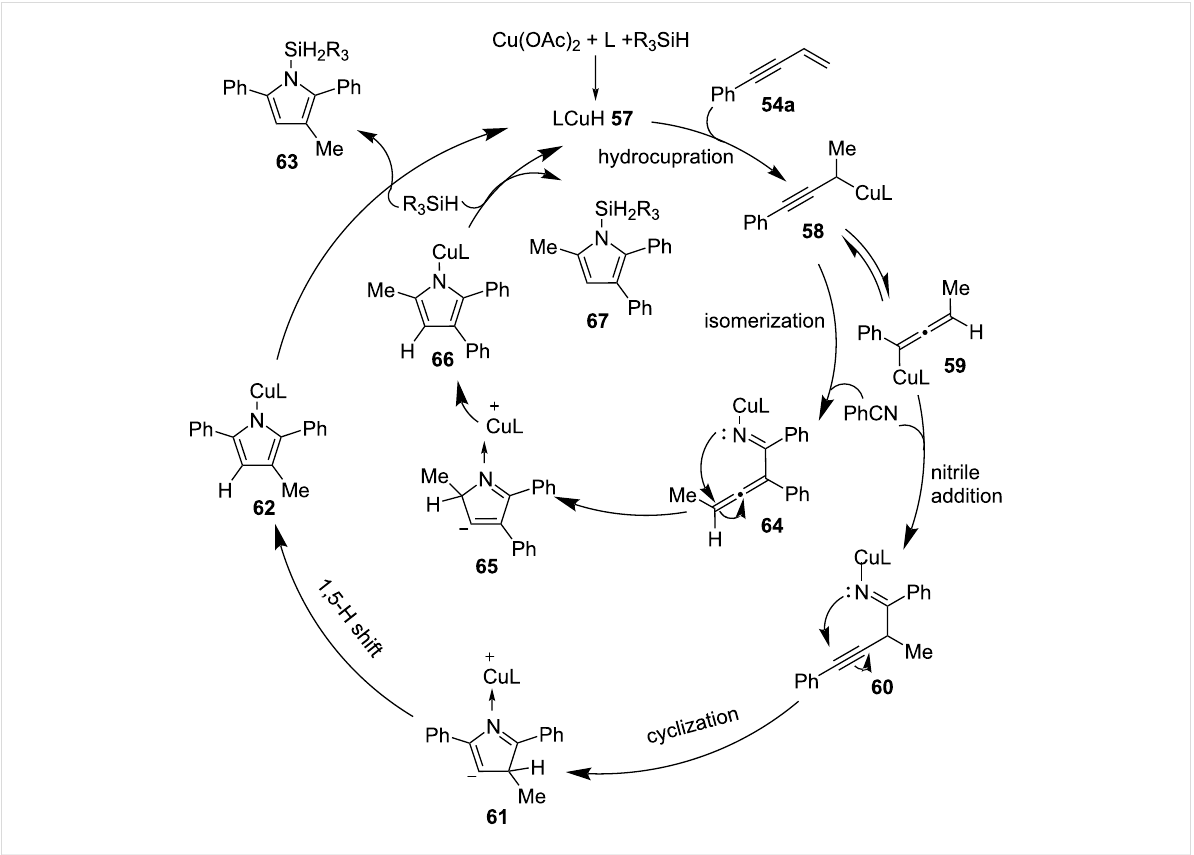
Scheme 22: The mechanism of CuH-catalyzed coupling of 1,3-enynes and nitriles to